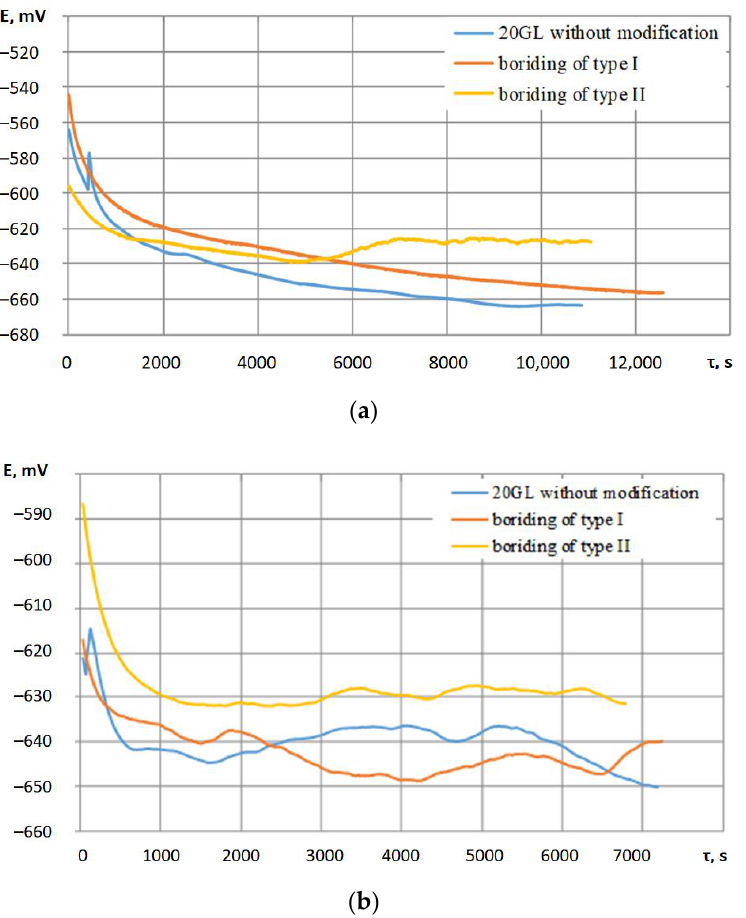
Figure 4. Typical relationship between the thickness of the boride layer and the corrosion potential of steel 20GL: ( a ) medium of 3% NaCl; ( b ) medium of 0.7% Na 2 SO 4 ; τ is time of exposure (s).